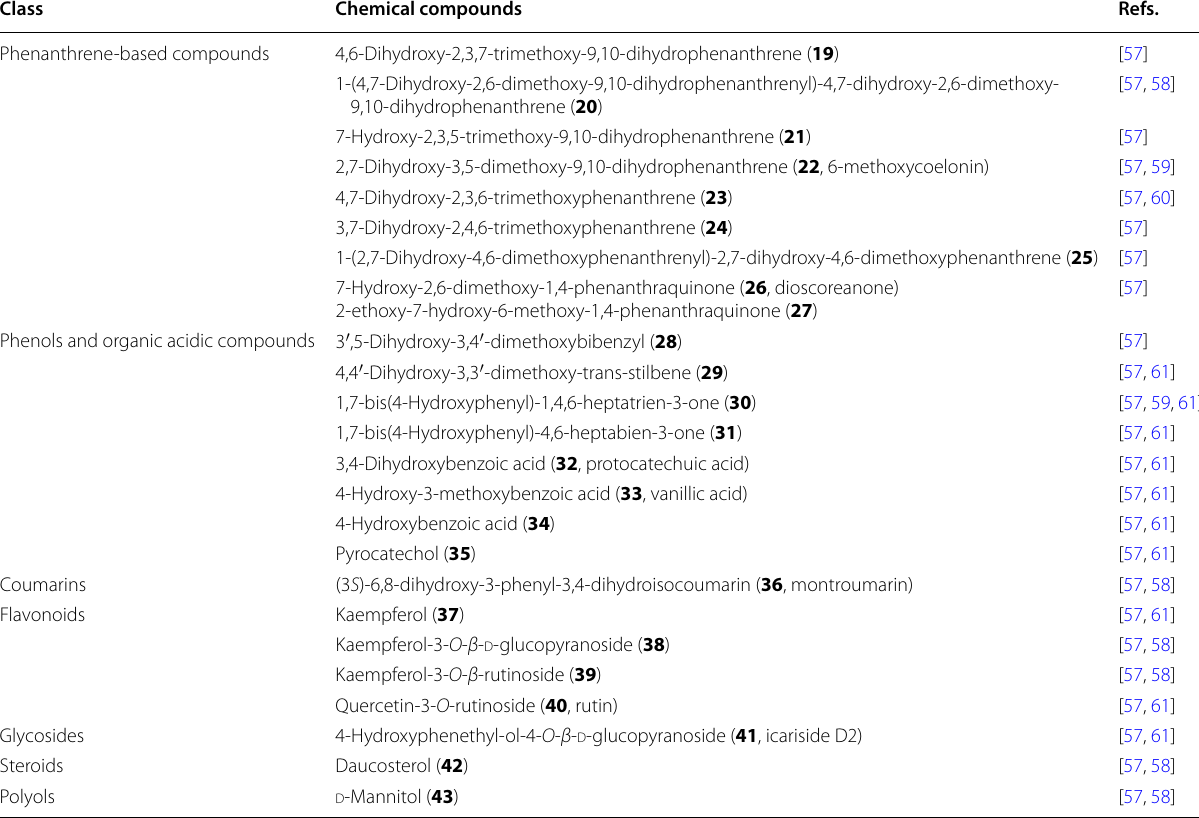
Table 1 The chemical constituents occurring in the aboveground portion of D. nipponica Class Chemical compounds